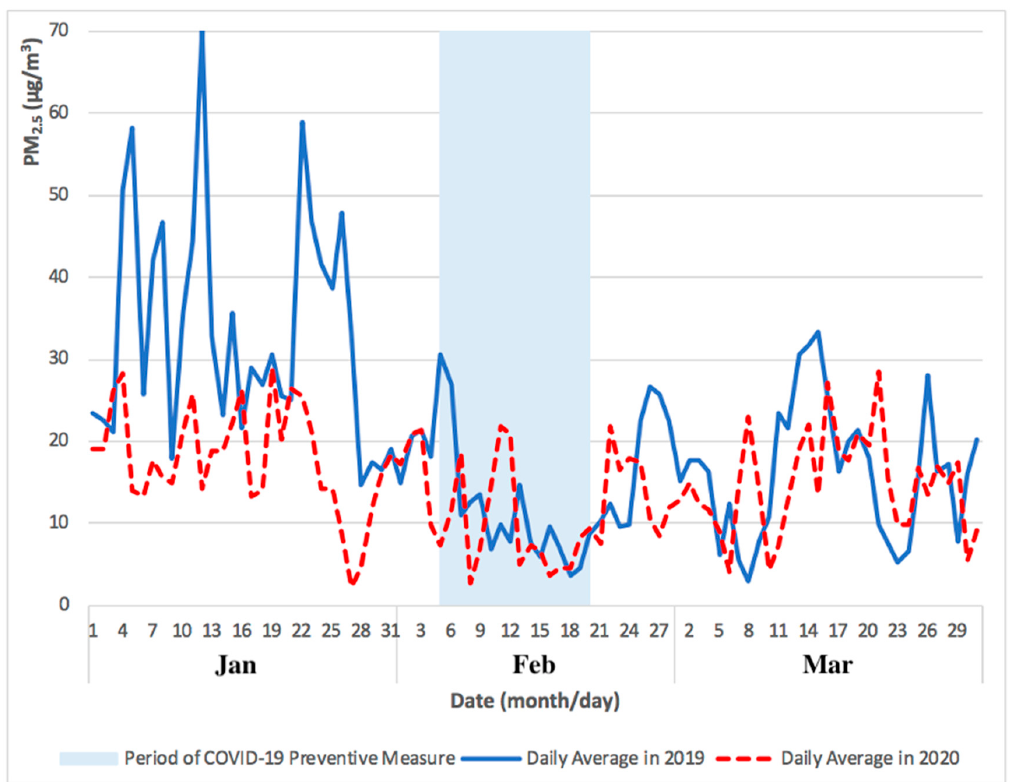
Figure 3. Comparison of PM 2.5 concentrations for Taipa Ambient during the previous year of 2019 and COVID-19 pandemic in 2020 (January to March). Int. J. Environ. Res. Public Health 2020 , 17 , x